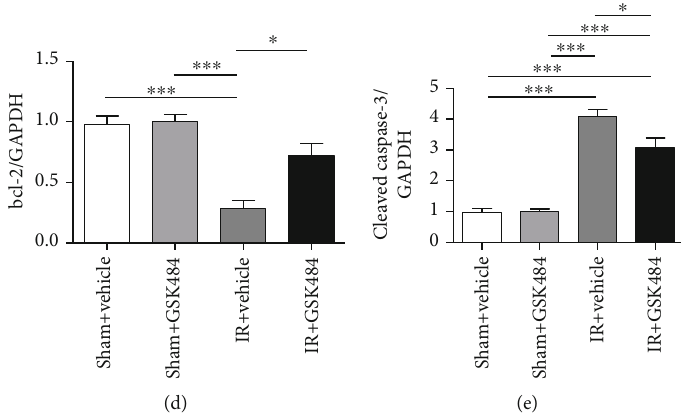
Figure 7: E ff ect of GSK484 on apoptosis in the lungs after renal IR-induced lung injury. (a) TUNEL staining was performed on lung sections (scale bar: 50 μ m). (b) Quanti fi cation of TUNEL-positive cells ( n = 6 ). (c) – (e). Western blot analysis of the Bcl-2 and cleaved caspase-3 expression in the lungs ( n = 3 ). The values are presented as the means ± SEMs . ∗ p < 0 : 05 , ∗∗ p < 0 : 01 , and ∗∗ p < 0 : 001